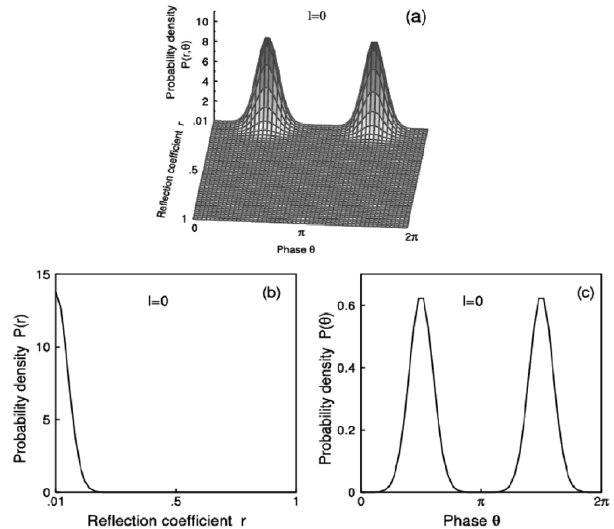
Figure 1. Initial probability distribution, i.e., when the sample length l = 0: ( a ) Probability distribution P ( r , θ ). ( b ) Marginal reflection probability distribution P ( r ). ( c ) Marginal phase probability distribution P ( θ ).